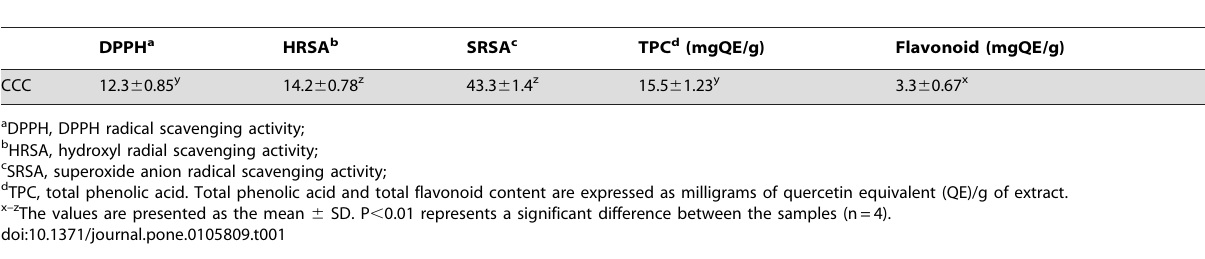
Table 1. Antioxidant capacities, total phenolic and flavonoids content of the CCC extracts.